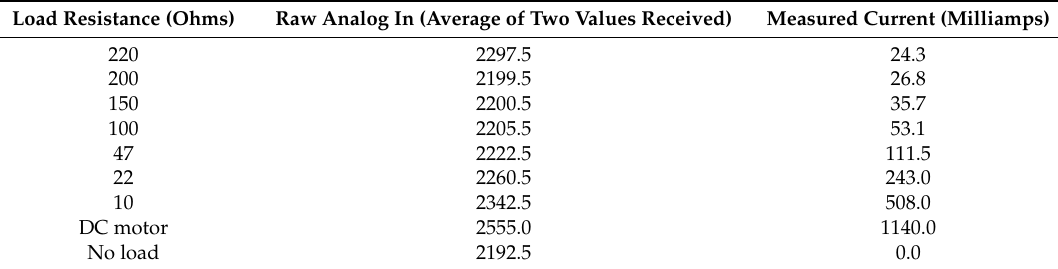
Figure 1. Graph of data with m value of 0.3181. Table 2. Hall magnetic sensor data from different loads.